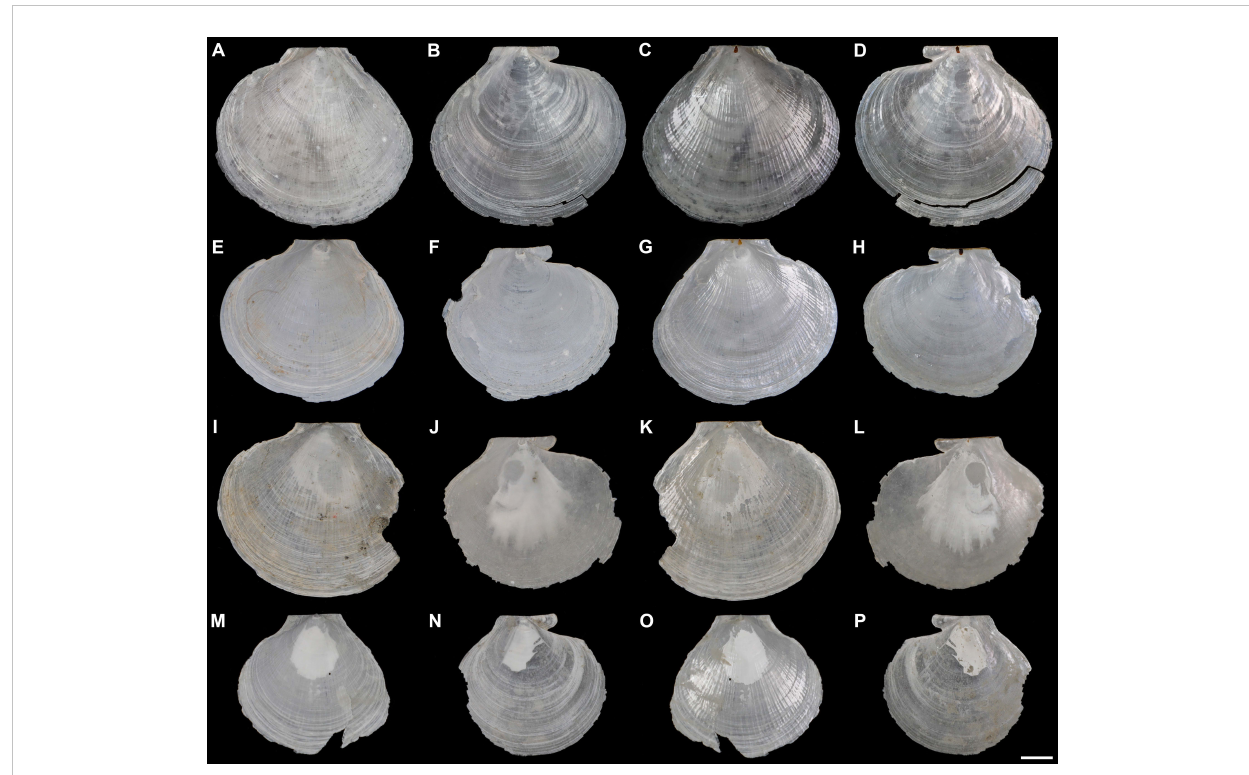
FIGURE 2 External and internal views of the left and right valves of Catillopecten margaritatus n. sp. specimens. (A – D) Holotype, TMBC, SCSMBC031006; (E – H) paratype 2, TMBC, SCSMBC031008; (I – L) paratype 3, TMBC, SCSMBC031009; (M – P) paratype 4, TMBC, SCSMBC031010. Scale bar: 5